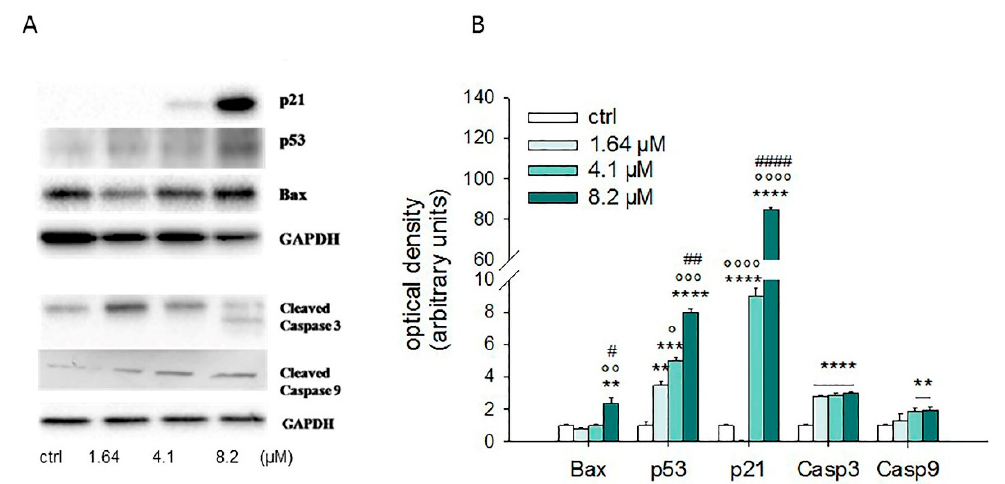
Figure 6. E ff ects of moringin on expression of apoptosis-related proteins. ( A ) Immunoblot of SH-SY5Y cells exposed to 1.64–8.2 µ M of moringin for 24 h: results of a representative experiment are shown. ( B ) Densitometric analysis of immunoreactive bands from three independent blots are reported. Levels are extrapolated as values detected in control cells, which are arbitrarily assigned as 1. ** p < 0.01, *** p < 0.001, and **** p < 0.0001 vs. untreated culture; ◦ p < 0.05, ◦◦ p < 0.01, ◦◦◦ p < 0.001, and ◦◦◦◦ p < 0.0001 vs. moringin 1.64 µ M; # p < 0.05, ## p < 0.01, and #### p < 0.0001 vs. moringin 4.1 µ M.